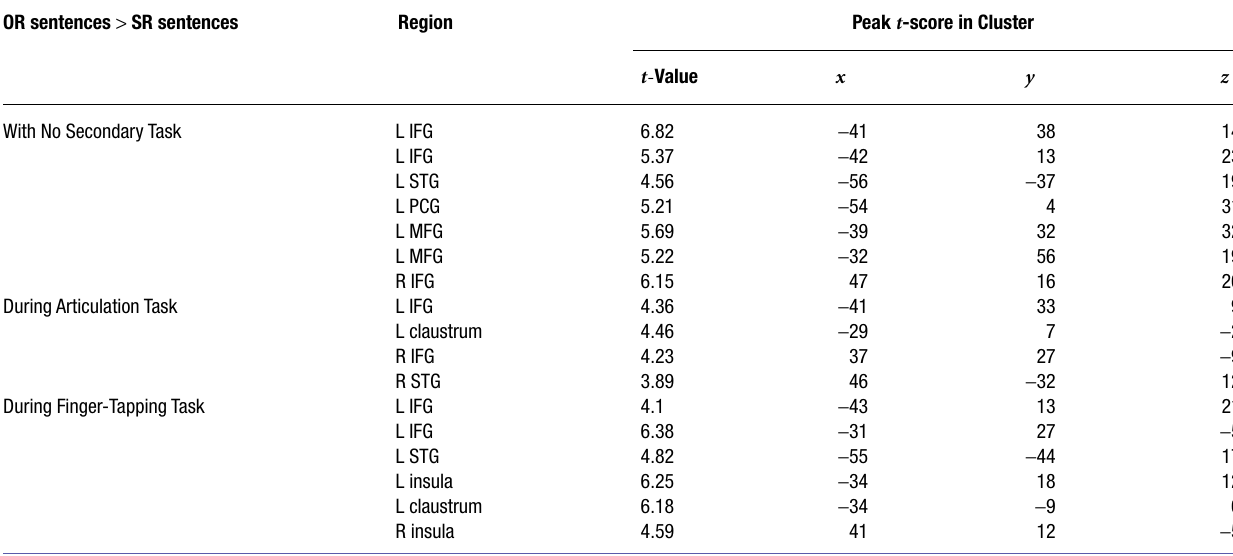
Table 3 | Peak t -values and talairach coordinates for these peaks (as well as approximate region based on these coordinates) for all voxel clusters that passed threshold ( p < 0.005) for the OR versus SR sentence contrast in each condition, averaged across trials and subjects. OR sentences > SR sentences